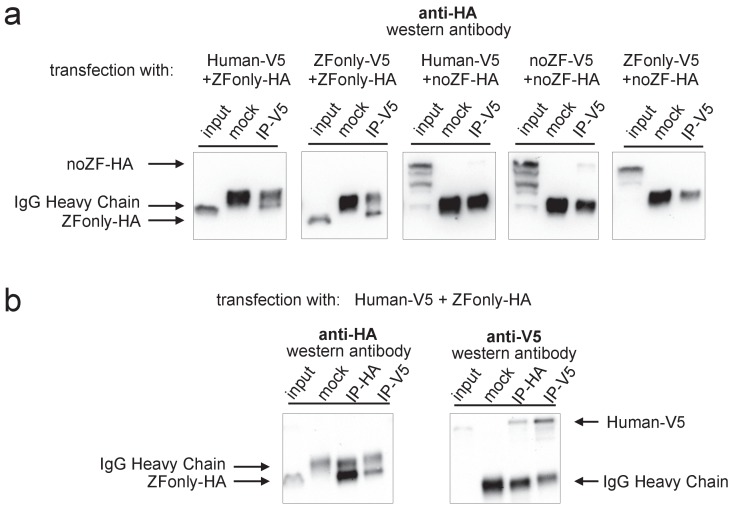
Multimerization is mediated primarily by ZF-ZF binding.Western blots illustrating co-IP results for various combinations of full-length Human, noZF, and ZFonly constructs. (a) The third and fourth blots show only a very faint co-IP signal despite strong input expression of the noZF construct, indicating that the non-ZF portion of PRDM9 cannot form multimers efficiently with itself or full-length PRDM9. The first and second blots show strong co-IP signals for the ZFonly construct, indicating that the ZF domain binds itself and binds the full-length Human construct. The fifth plot shows that the ZFonly and noZF constructs do not bind each other and confirms that multimerization is not mediated by the C-terminal tags. (b) A replication of the experiment shown in the first blot above, but performing the IPs and western blots with both tag combinations. This confirms that the full-length Human construct can pull down the ZFonly construct, and the ZFonly construct is sufficient to pull down the full-length Human construct.